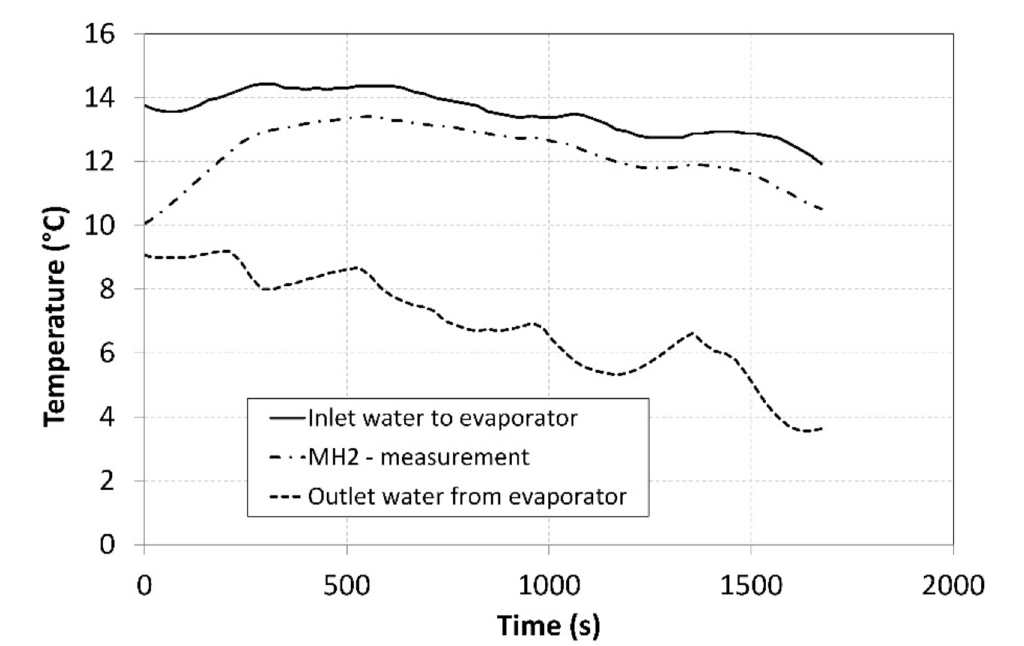
Figure 10. Thermal management of cooling the MH2